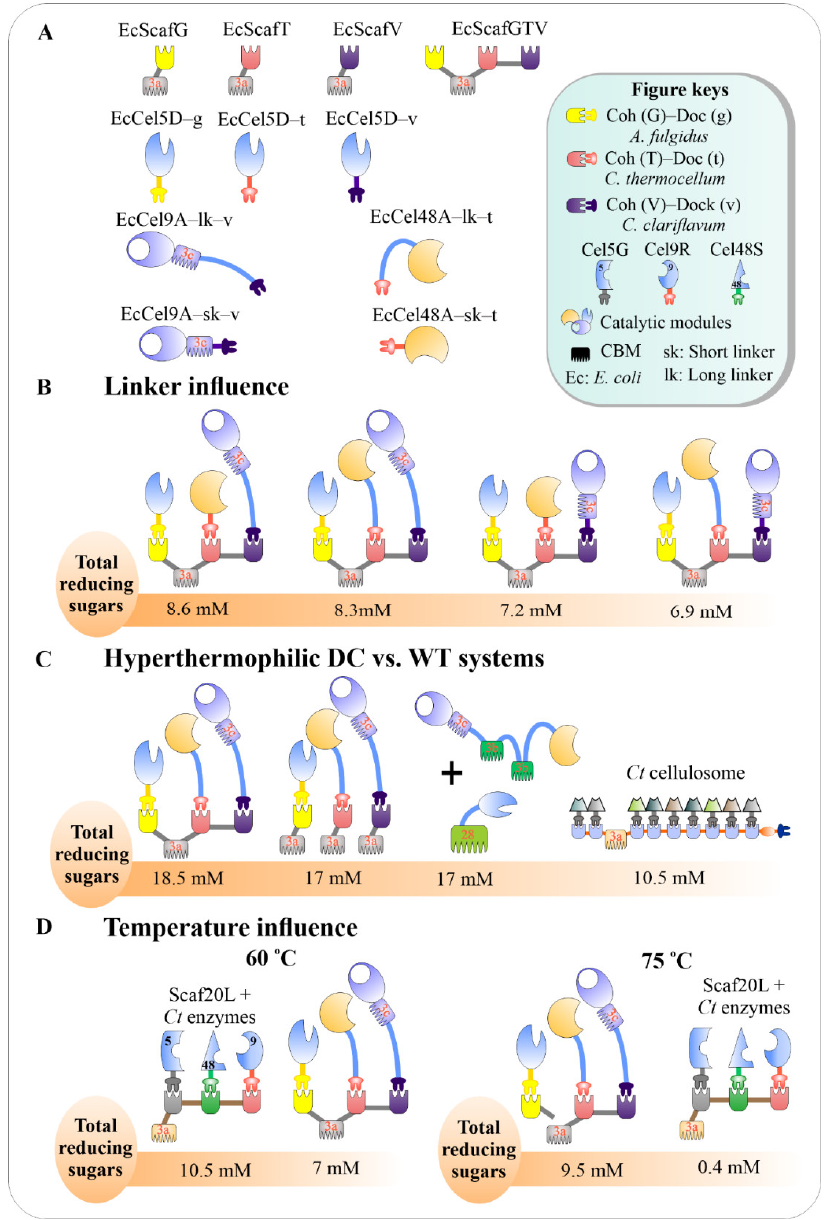
Figure 7. Development of E. coli -based DC. ( A ) Conversion of the wild-type (WT) C. bescii Cel9A, Cel48A into chimeric forms using E. coli as an expression host. ( B ) Influence of linker length in DC enzyme components on hydrolytic efficiency (24 h of incubation at 75 °C, 4% ( w / v ) Avicel). ( C ) Com- parison of hydrolytic activities between C. bescii -based DC, chimeric C. bescii enzymes, WT C. bescii enzymes, and native Ct cellulosome, (72 h of incubation at 75 °C, 4% ( w / v ) Avicel). ( D ) Effects of temperature on the activities of C. thermocellum -based DC and C. bescii -based DC (72 h of incubation at 75 °C, 4% ( w / v ) Avicel).